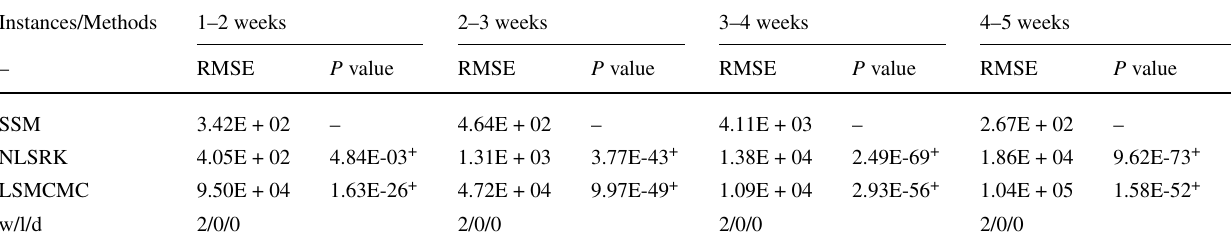
Table 7 Comparison results with numerical methods for simulation days being 7 days ( T 1 (cid:2) 7) Instances/Methods